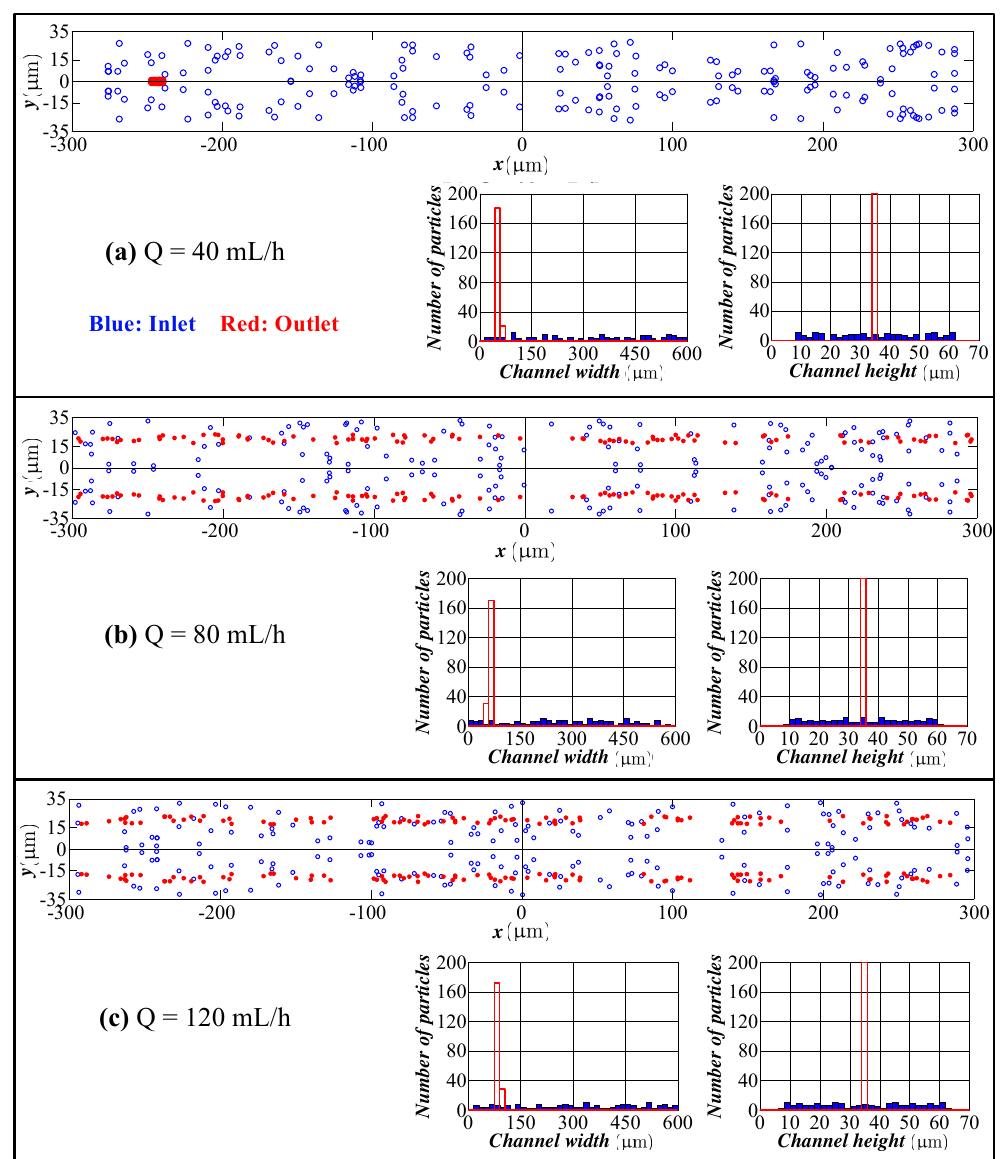
Figure 6. Particle distribution at the inlet and outlet in the height and width directions for different flow rates (spiral channel with an AR 9.0, 10 µ m particles). Flow rate: ( a ) 40 mL/h; ( b ) 80 mL/h; ( c ) 120 mL/h. Blue bars: particle distribution at the inlet. Red bars: particle distribution at the outlet. Figure 7 shows the cross-sectional view and distribution of particles at the inlet and outlet of the channel for 20 µ m particles. In this case, the focusing is very clear, and the location of the equilibrium position shifts to the inner wall as flow rate